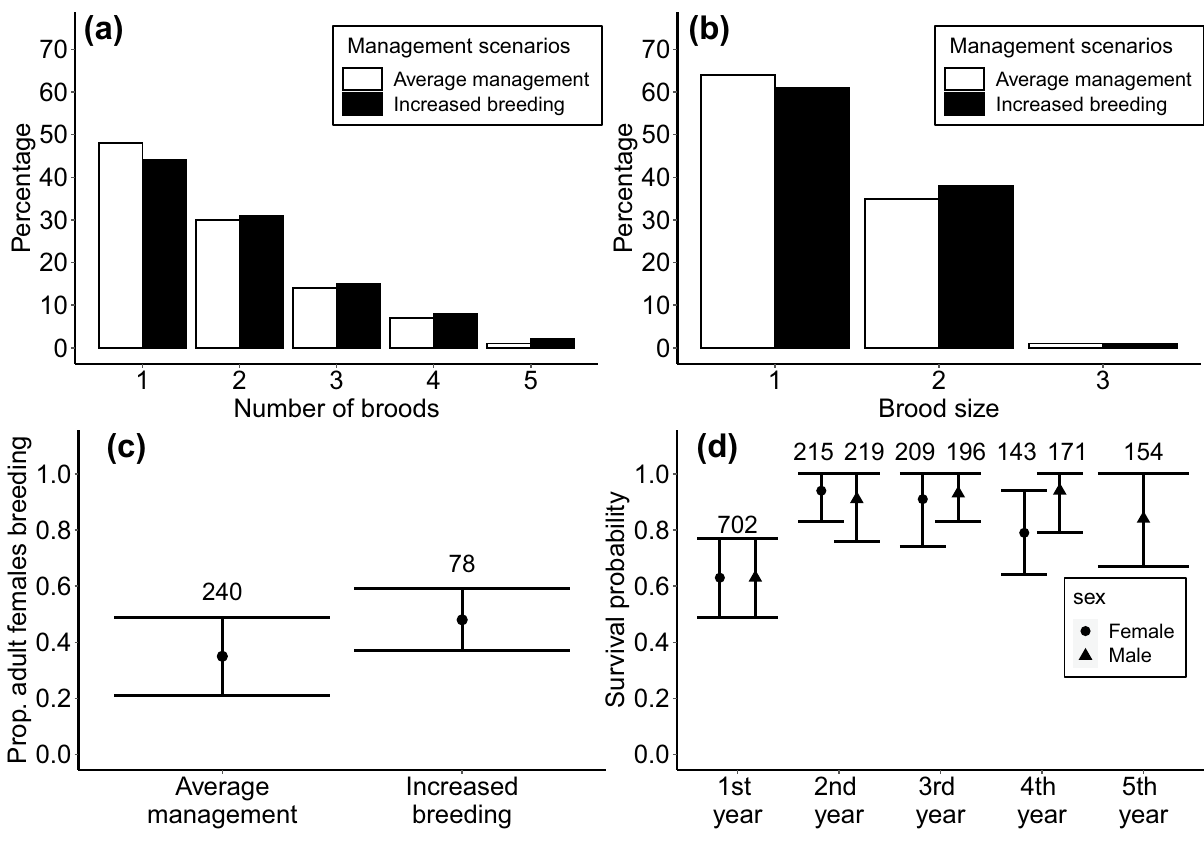
Figure 2. Demographic rates from the sihek ex-situ population used in population models of management scenarios. ( a ) Number of broods produced and ( b ) brood size given breeding, ( c ) proportion of adult females breeding per year (i.e. producing ≥ 1 hatchling) with associated standard deviations, and ( d ) sex-age class survival probabilities with associated standard deviations. In ( d ), females and males were pooled for estimation of first-year survival probability. Female fourth-year survival probability represents survival probability of females aged 3 +, male fifth year survival probability represents survival probability of males aged 4 +. For ( c ) and ( d ) associated sample sizes are shown above each error